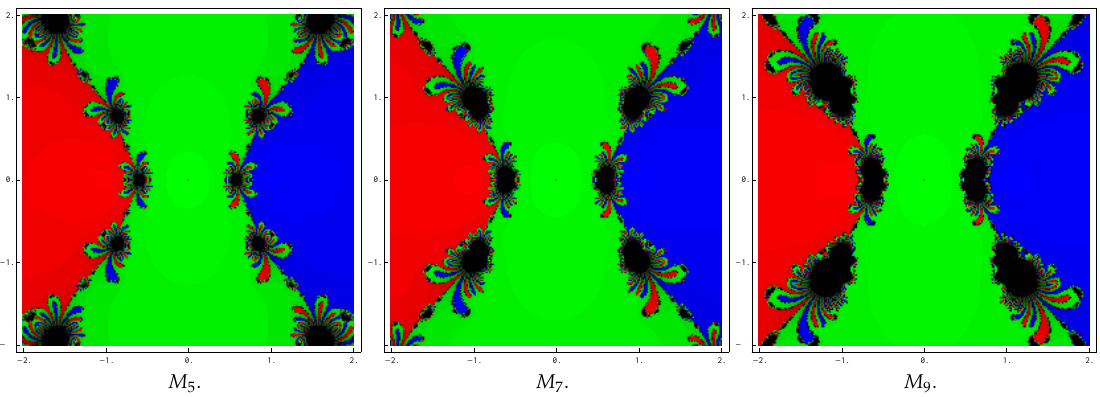
Figure 7. Basins of attraction of M 5 , M 7 , and M 9 for polynomial P 2 ( z ) .